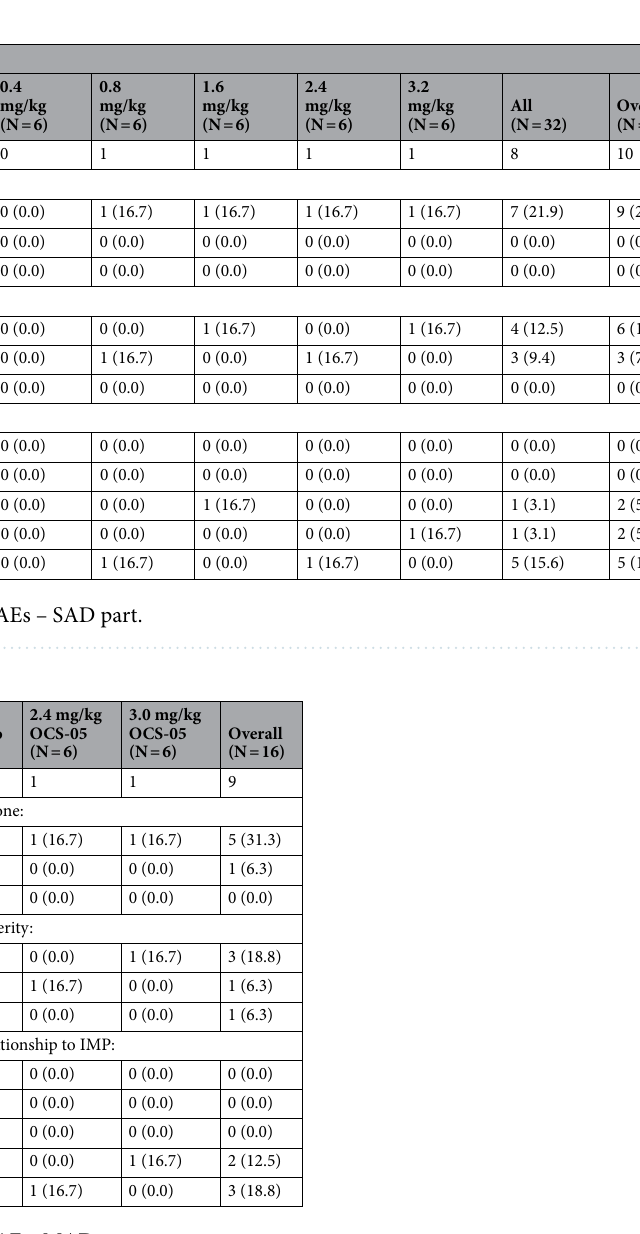
Table 3. Overall summary of TEAEs–MAD